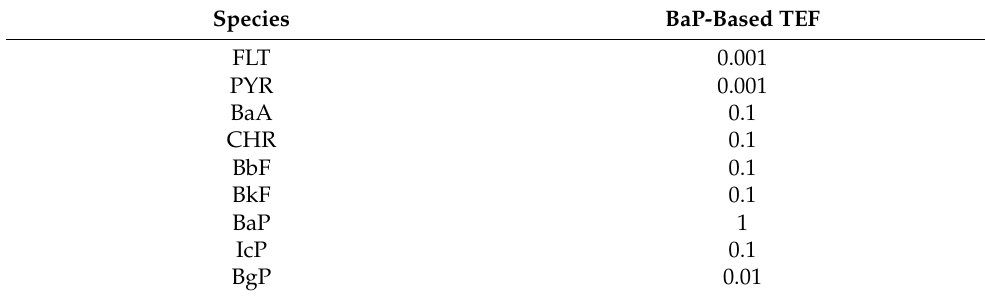
Table 2. Toxic equivalent factors (TEFs) of individual PAHs (USEPA, 2010).